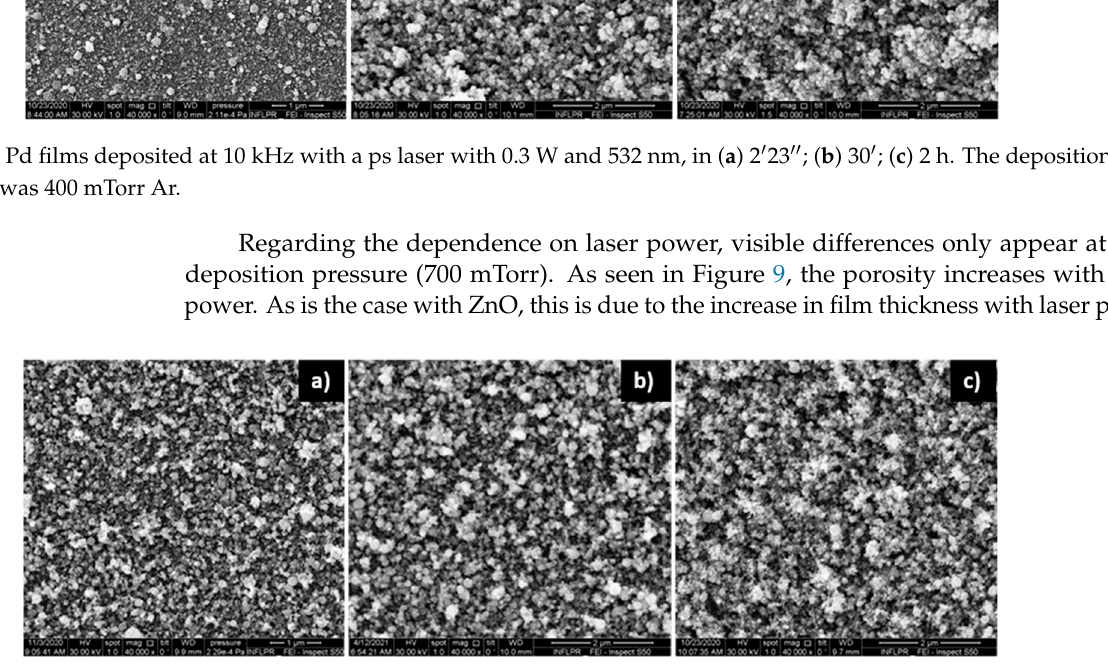
Figure 9. SEM images of the Pd thin film surface. Films were deposited in 700 mTorr Ar with a ps laser, using 532 nm radiation, at 10 kHz, in 30’, using an average power of ( a ) 0.1; ( b ) 0.2 W; ( c ) 0.3 W.